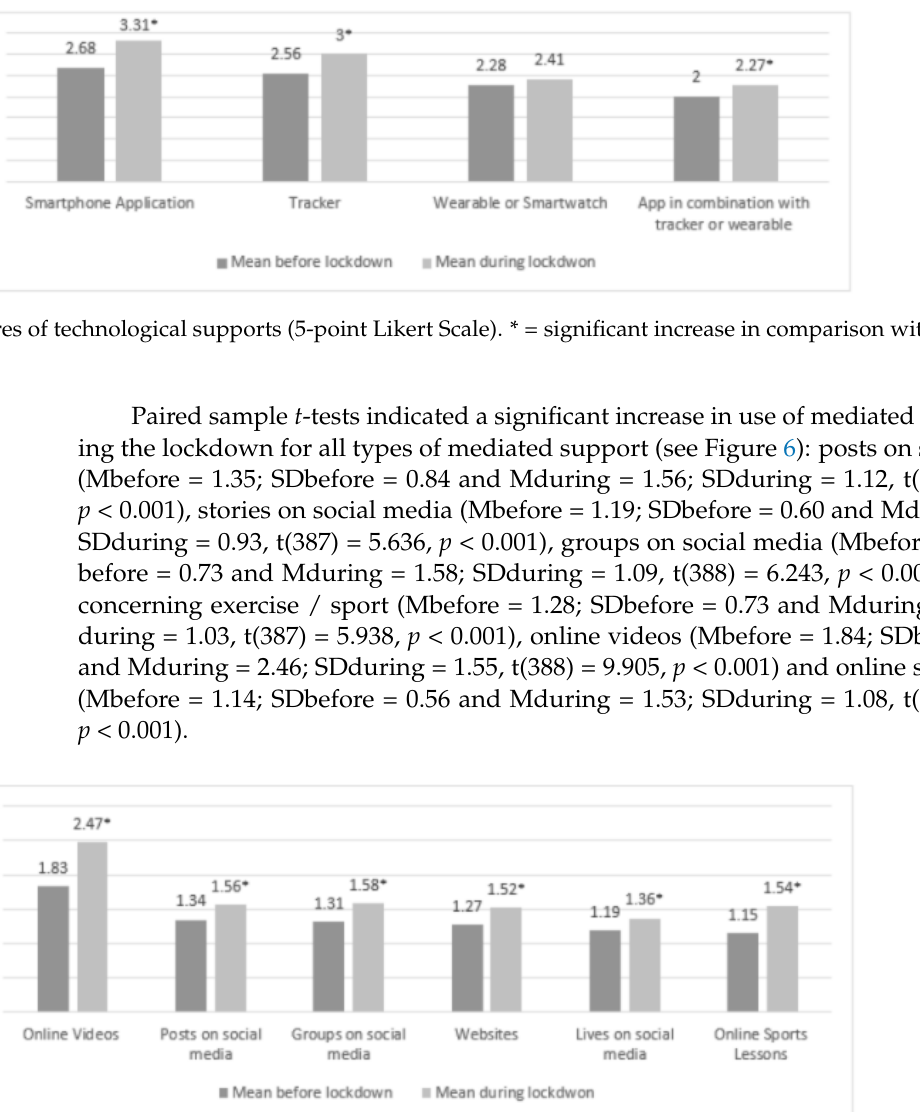
Figure 6. Mean scores of mediated supports (5-point Likert Scale). * = significant increase in com- parison with before the lockdown.